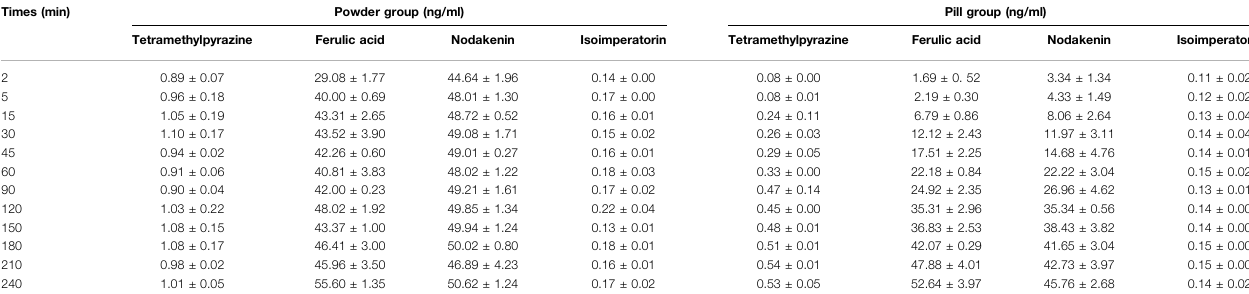
TABLE 5 | Cumulative dissolution rates of tetramethylpyrazine, ferulic acid, nodakenin, and isoimperatorin ( n = 3, Times (min) Powder group (ng/ml) Pill group (ng/ml) Tetramethylpyrazine